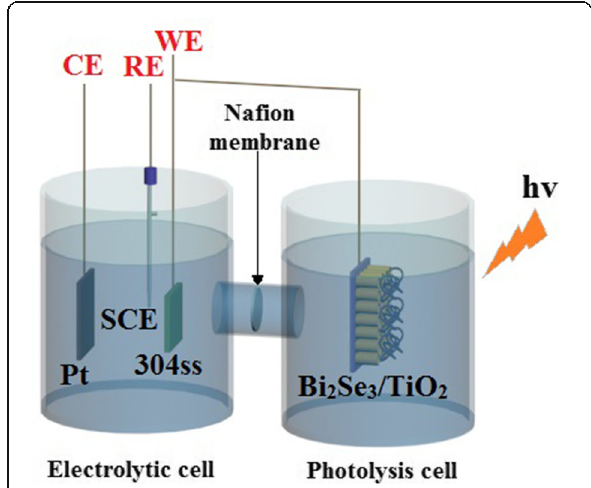
Fig. 1 Schematic sketches of the experimental setup used for photoelectrochemical